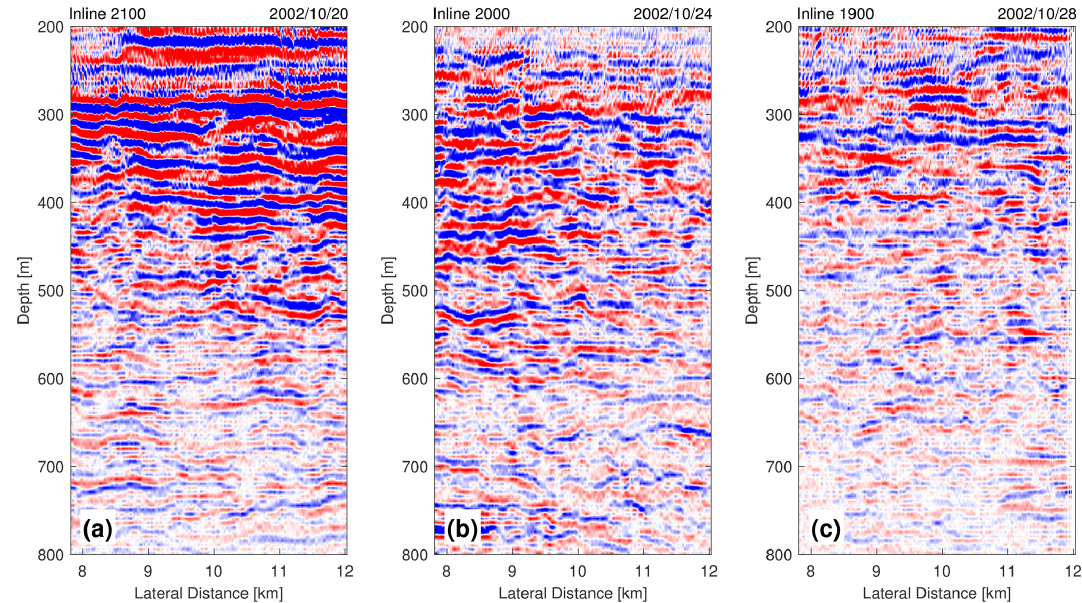
Figure 5. Three seismic inline images illustrating temporal variation of the water column. (a) IL #2100, (b) IL #2000, and (c) IL #1900. Inline numbers and the date of collection are noted on the top. The temporal and spatial separation between images is 4d and 2.5km, respectively.